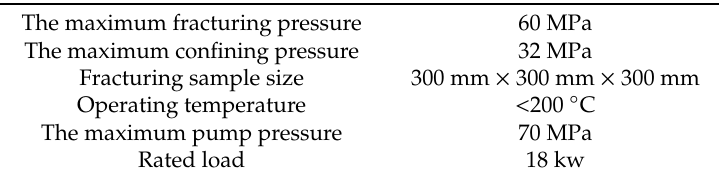
Table 1. Main technical parameters of the equipment.